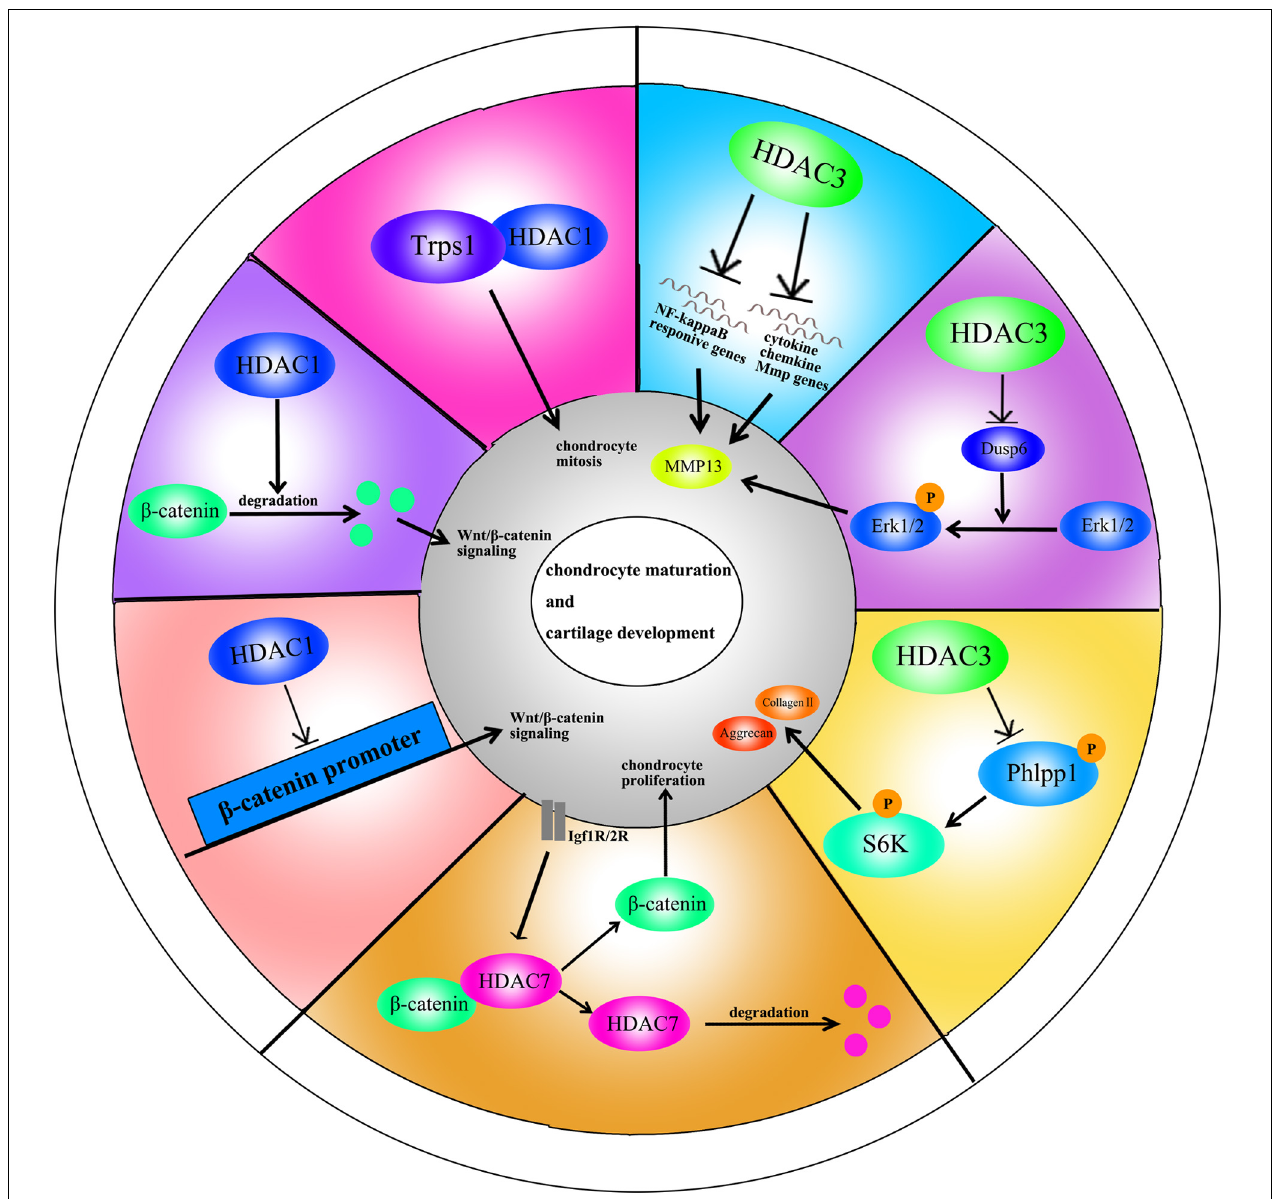
FIGURE 2 | A schematic illustration of HDACs in chondrocyte maturation and cartilage development through different signaling